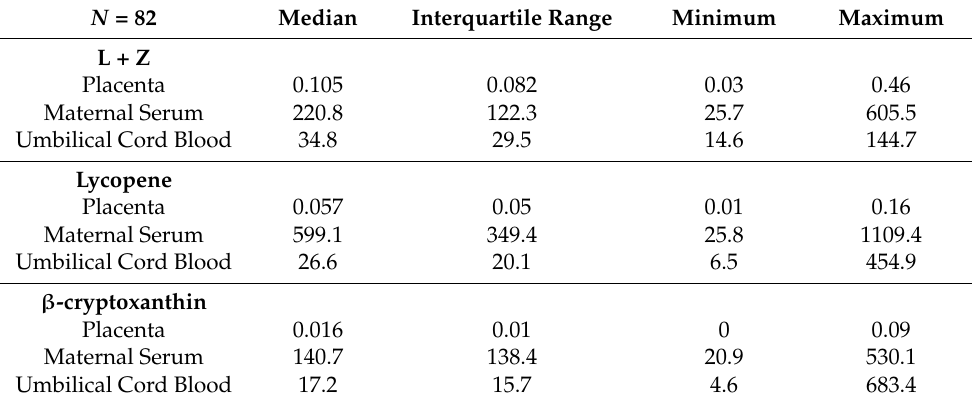
Table 4. Carotenoid levels in placental tissue (mcg/g) and blood samples